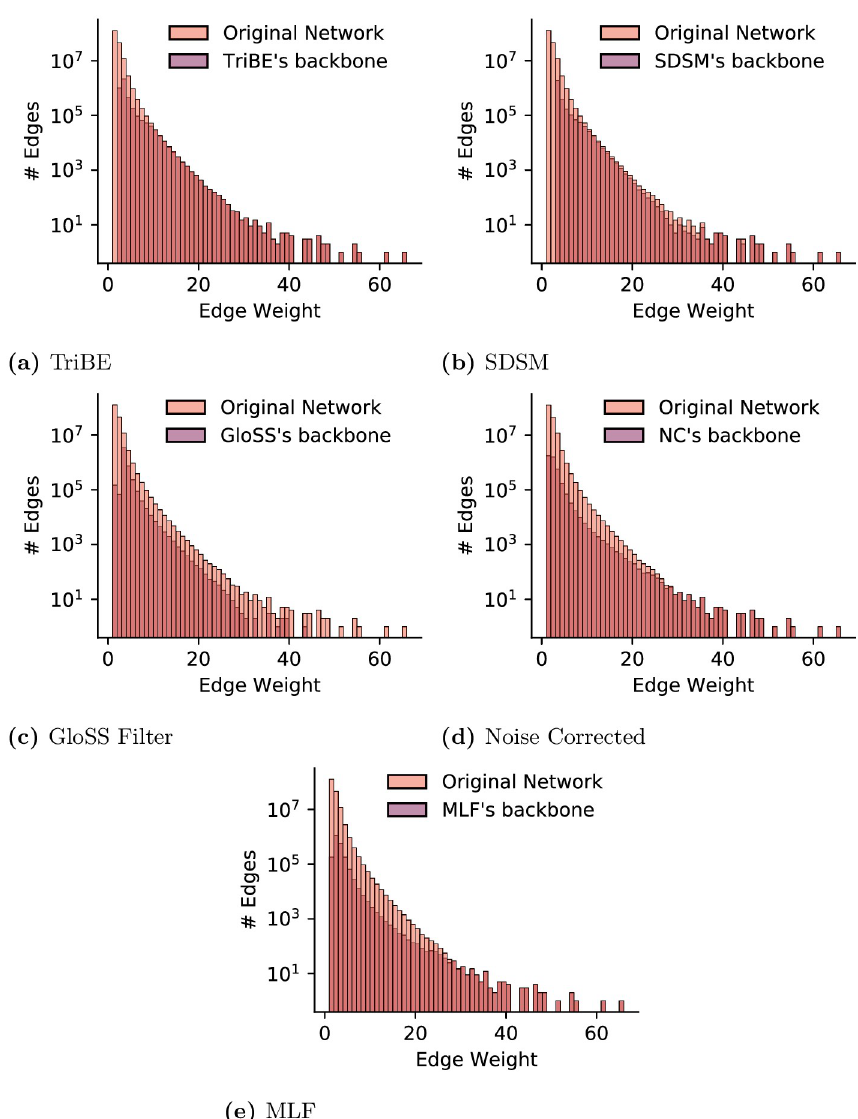
Fig 4. Online discussions on Instagram: Weight distribution for edges retained in the backbone by each method (distribution for original/complete network shown for comparison).